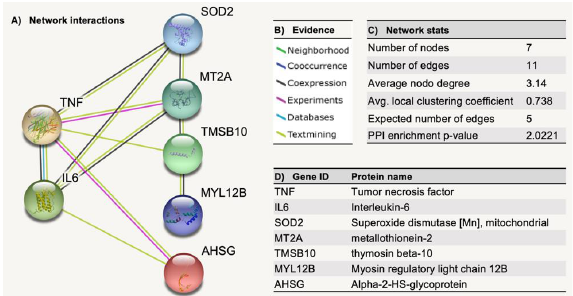
Figure 12. Protein–protein interaction networks functional enrichment analysis among the significantly upregulated proteins in human gingival fibroblast cells treated with EgPs and the key pro-inflammatory cytokines TNF- α and IL-6 using STRING, the Search Tool for the Retrieval of Interacting Genes/Proteins. Network nodes were proteins, and edges represented the predicted functional associations ( A ), drawn according to the type of evidence ( B ). Network statistics reporting data concerning the number of nodes and edges, the average node degree, the average local clustering coefficient, the expected number of edges, Table 5. Network interaction data. and the protein–protein interaction (PPI) enrichment p -value are shown in ( C ). Proteins, and their gene symbols, are listed in ( D